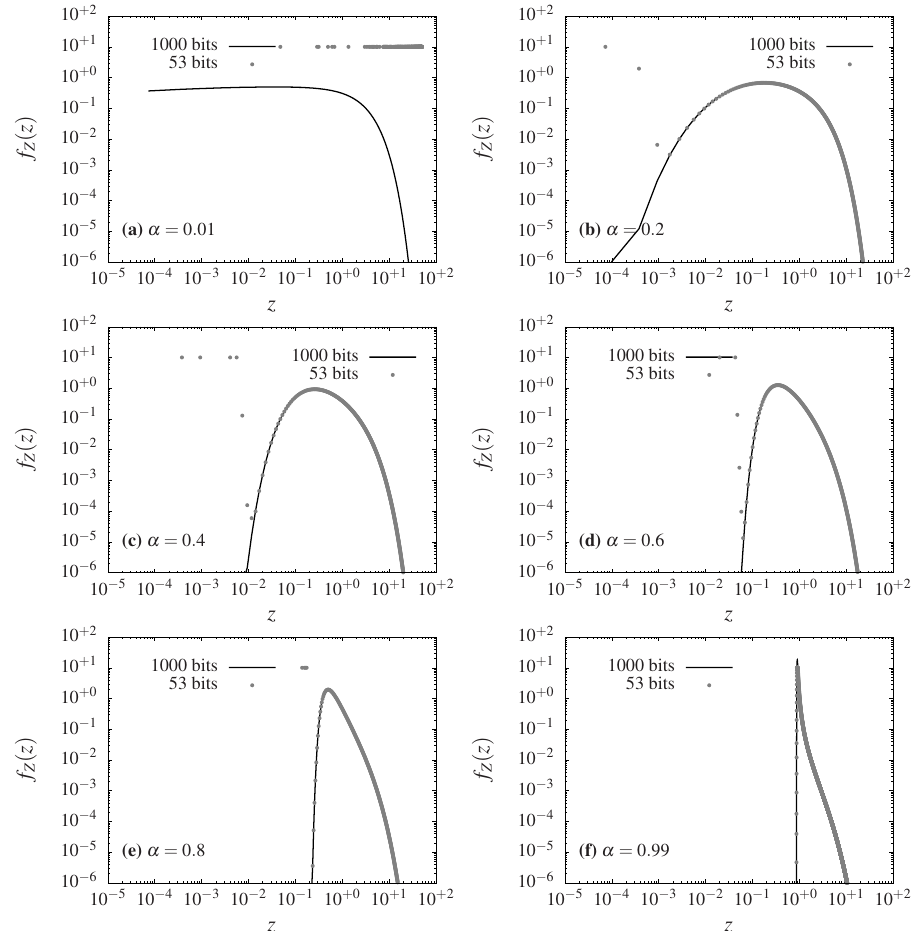
Figure 5 - Detailed verification of the convergence behavior of versions “np-nl” (continuous black line), and “dp-nl” (gray dots, with “dp-wl” being the same as “dp-nl”): (a) , α = 0.01 ; (b) , α = 0.2 ; (c) , α = 0.4 ; (d) , α = 0.64 ; (e) , α = 0.8 and (f) , α = 0.99